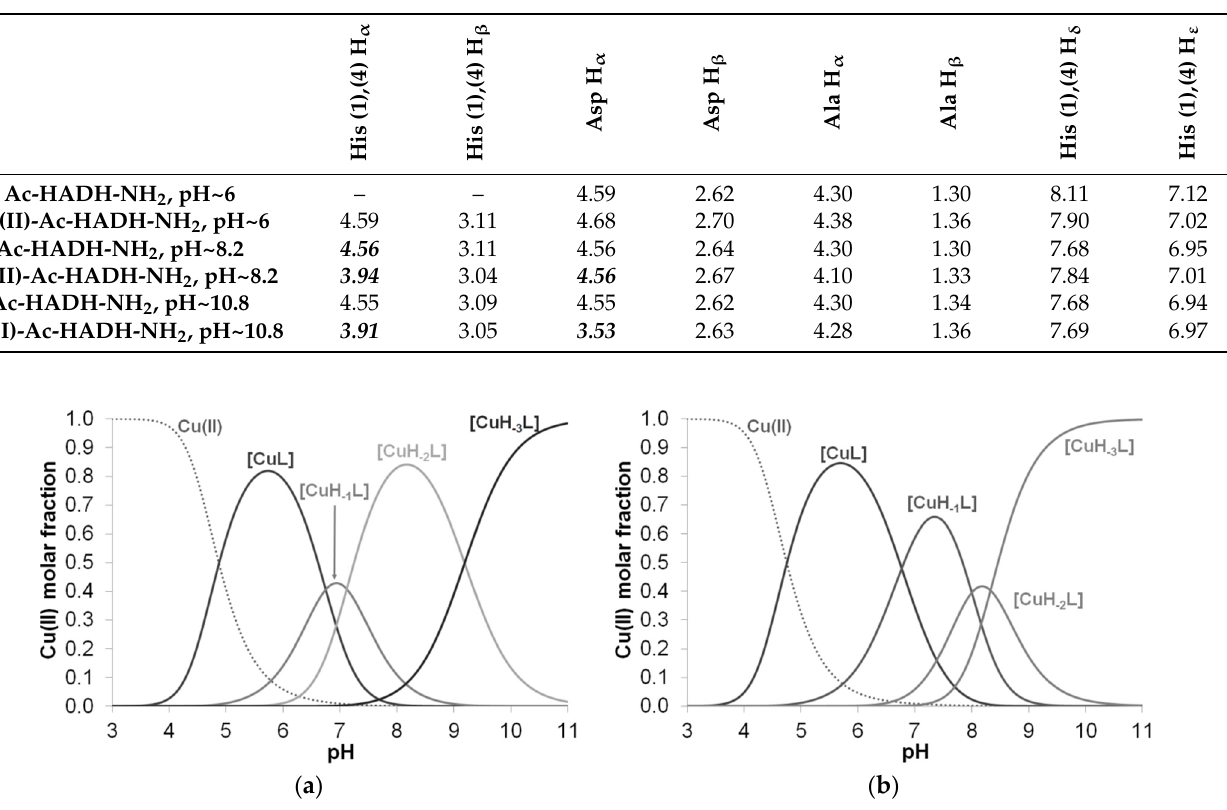
Figure A2. CD spectra registered in equimolar solution of Ac-HADH-NH 2 ( ■ ) and Ac-HDAH-NH 2 ( ■ ) systems at pH 11.5.